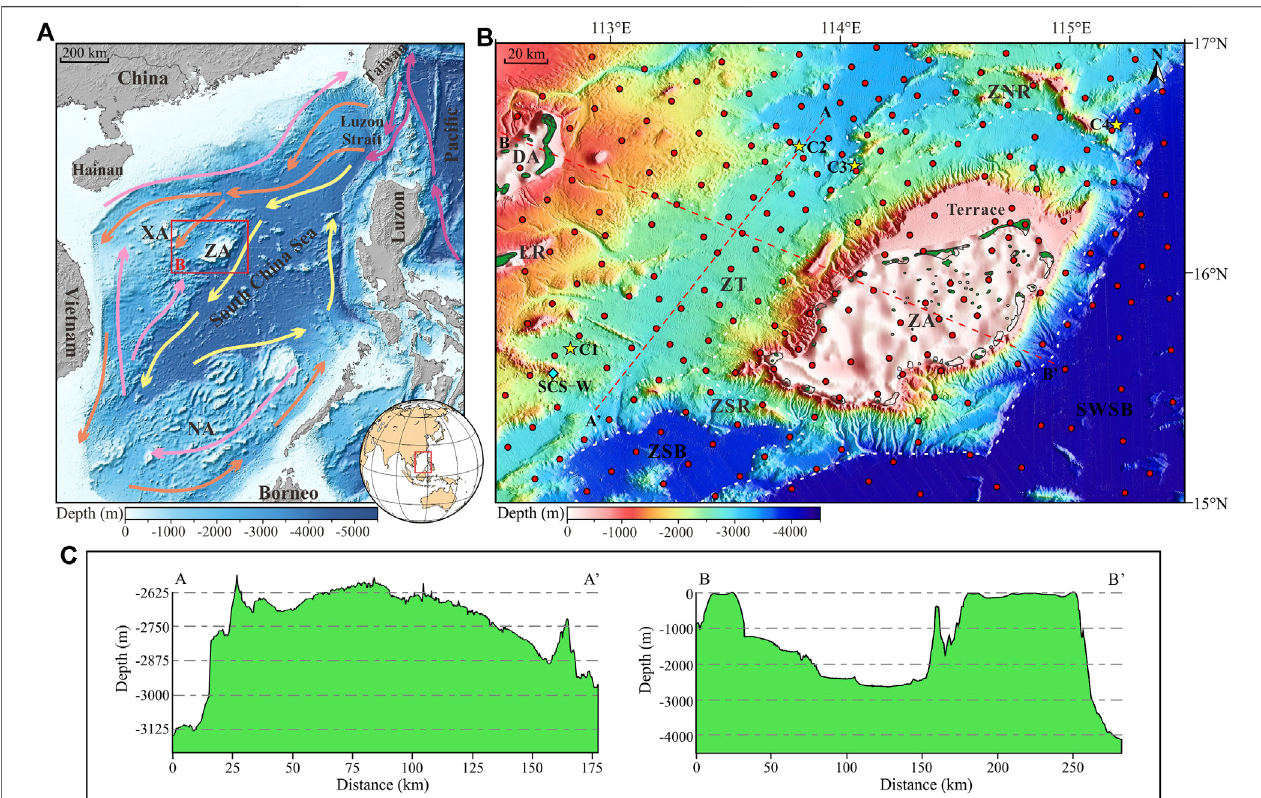
FIGURE 1 | Location, oceanography, and topography of the study area. (A) Bathymetric map of the SCS revealing the location of the study area. Purple arrows indicate the western Paci fi c waters entering the SCS through the Luzon Strait (Fang et al., 1998; Lüdmann et al., 2005). The surface circulation is indicated by orange arrows (winter) and pink arrows (summer) (Yang et al., 2002; Wang et al., 2018). The deep circulation is indicated by yellow arrows (Lan et al., 2015; Wang et al., 2018). (B) Multibeam bathymetric map showing the submarine topography of the study area. Green patches indicate the reefs. Red dots and yellow stars mark the 232 samplesand4ADCPstationsanalyzedinthisstudy,respectively.ThebluediamondindicatesasamplinglocationofLiuetal.(2018).Reddashedlinesindicatethepro fi le position displayed in Panel (C) . (C) Bathymetric pro fi les show the geometry of sea fl oor topography in the study area. ZA, Zhongsha Atoll; XA, Xisha Archipelagos;